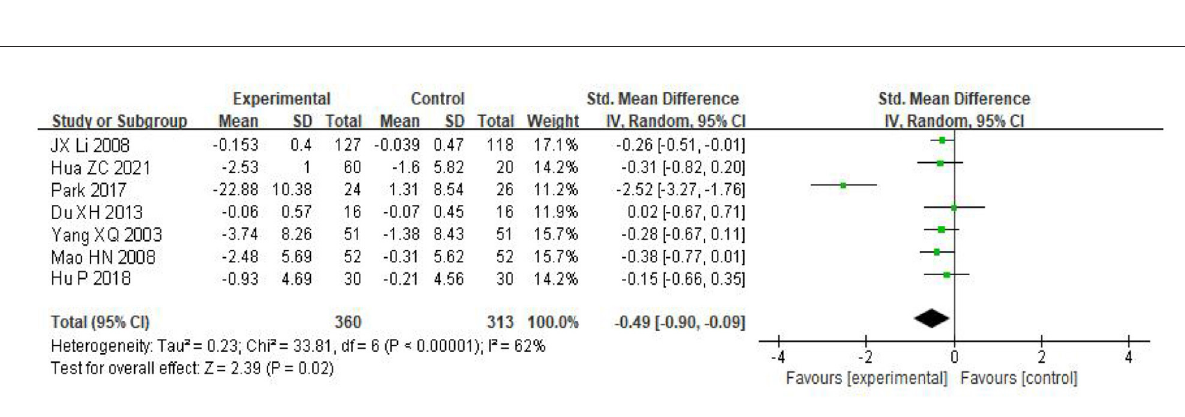
FIGURE4 Forest plot of the effect of taijiquan on college students’